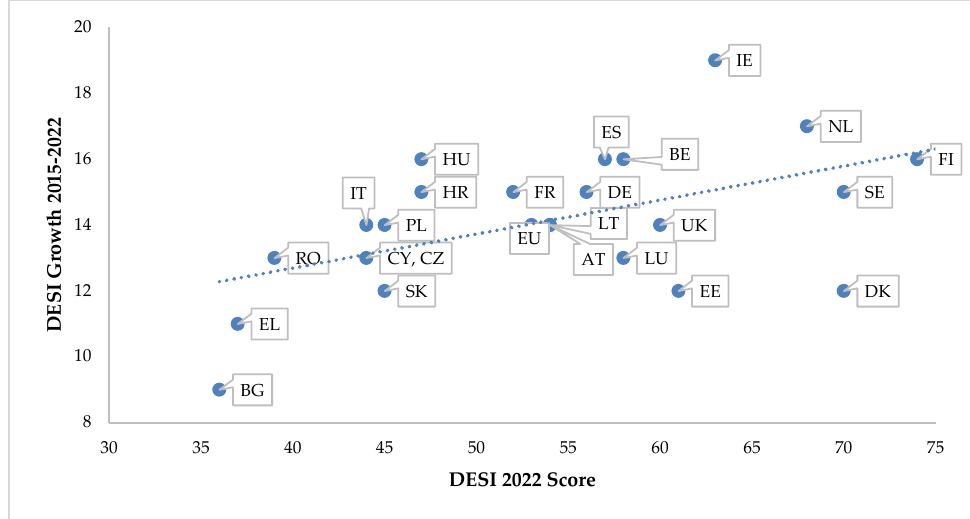
Figure 11. Digital Economy and Society Index—Progress of Member States, 2015–2022. Source: Authors’ compilation, according to [71] and cumulative data.